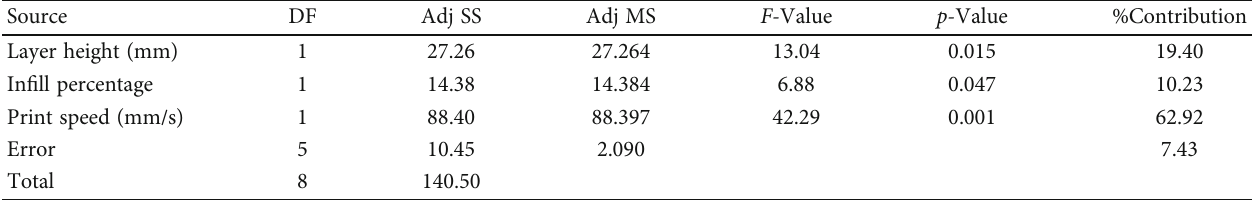
Table 4: Analysis of variance for fl exural strength.